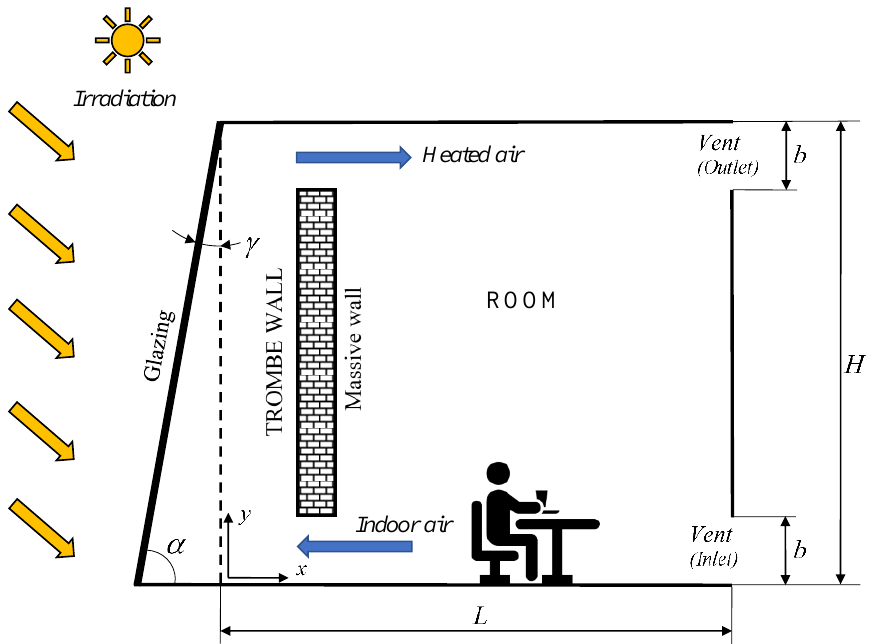
Figure 3. Typical arrangement of a Trombe wall attached to a room. The vents and apertures are placed to produce heating of indoor air (winter heating mode in the scheme). The thermally active walls (mainly the glazing) can be inclined ( α or γ angles).